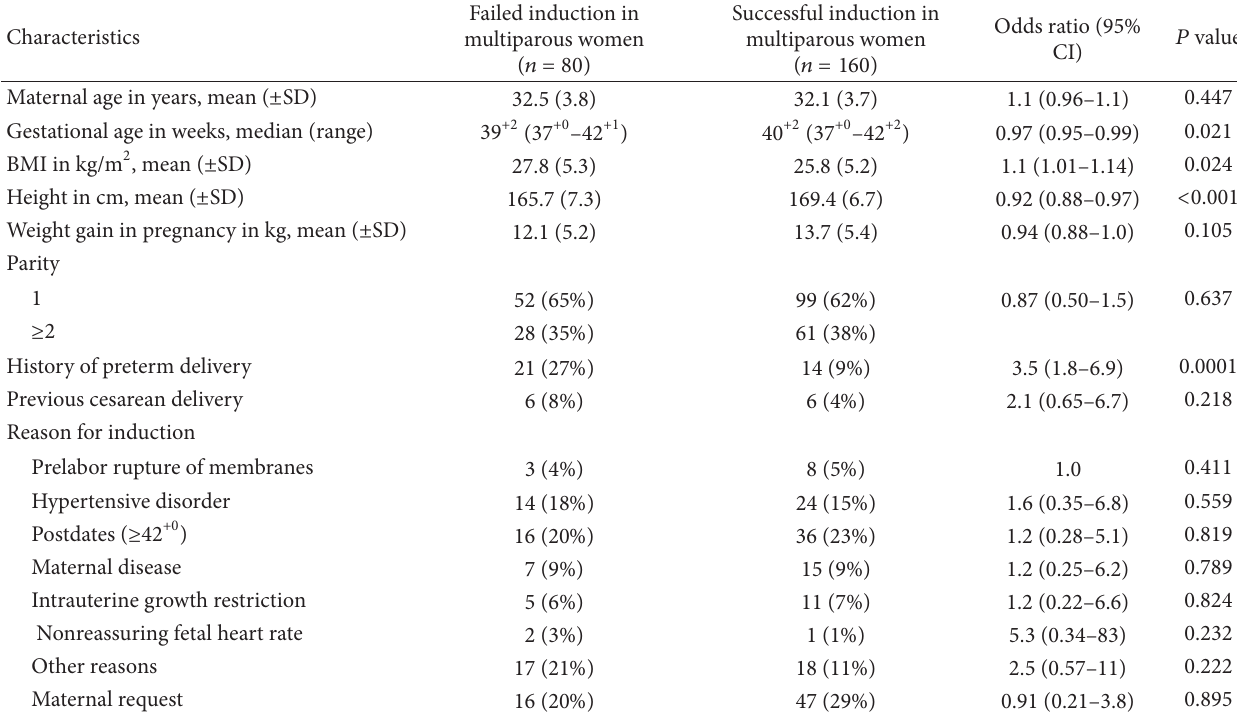
T 1: Characteristics of the study population at start of induction of